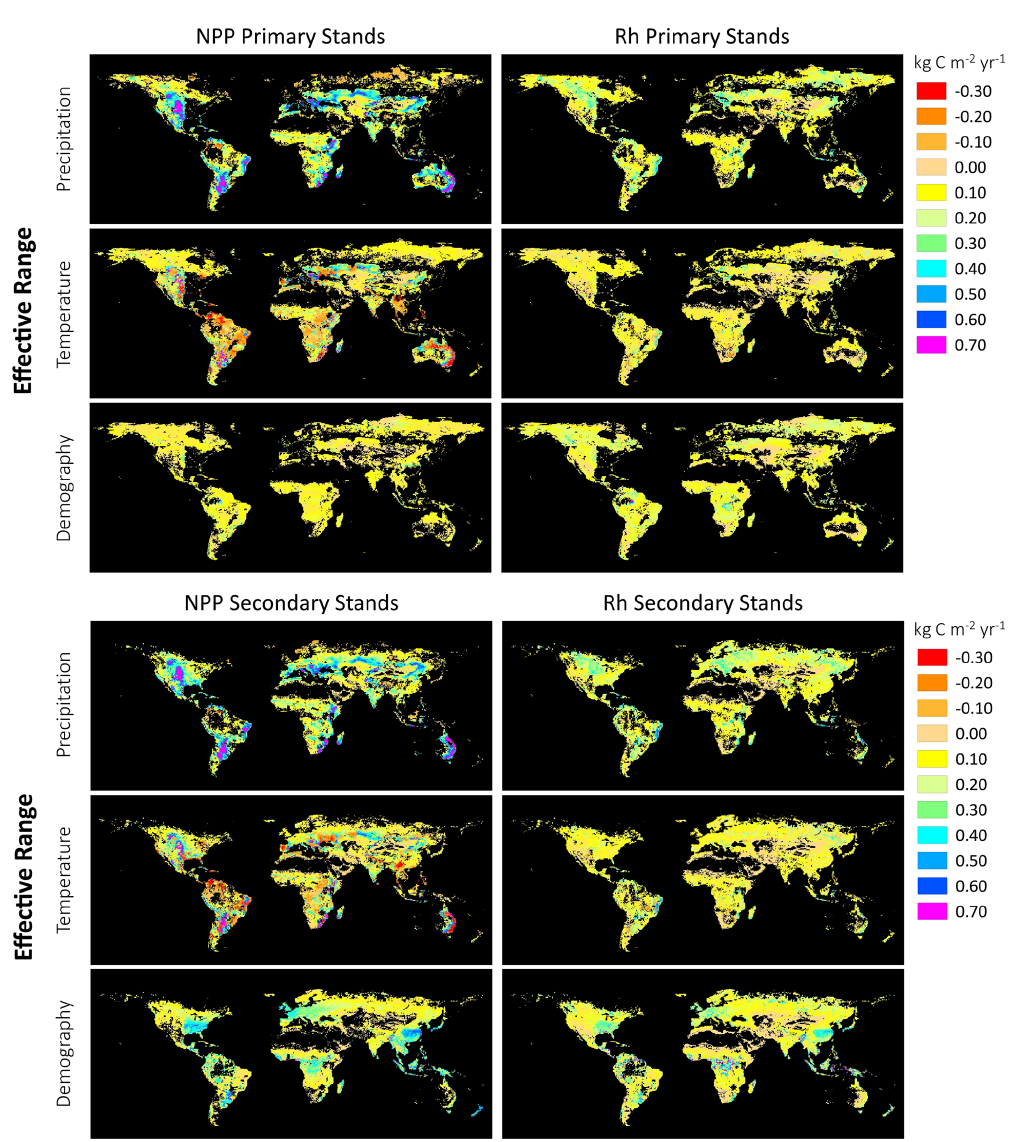
Figure 11. Global maps of the Effective Range of the Predictors (precipitation, temperature, demography) on LPJ-wsl v2.0 fluxes (NPP, Rh); black indicates zero values or no data. The effective range of the predictor is calculated as the grid-cell-specific beta ( β ) coefficient multiplied by the observed range of the predictor variable for the grid cell, for the years 2000–2017. Units are on the scale of the predicted flux (kgCm − 2 yr − 1 ). In these maps, an emphasis is placed on the effective range of the predictor rather than the absolute value of the coefficient, although these too can be mapped for forecasting purposes. See Sects. 2.3.5 and 3.4 for additional